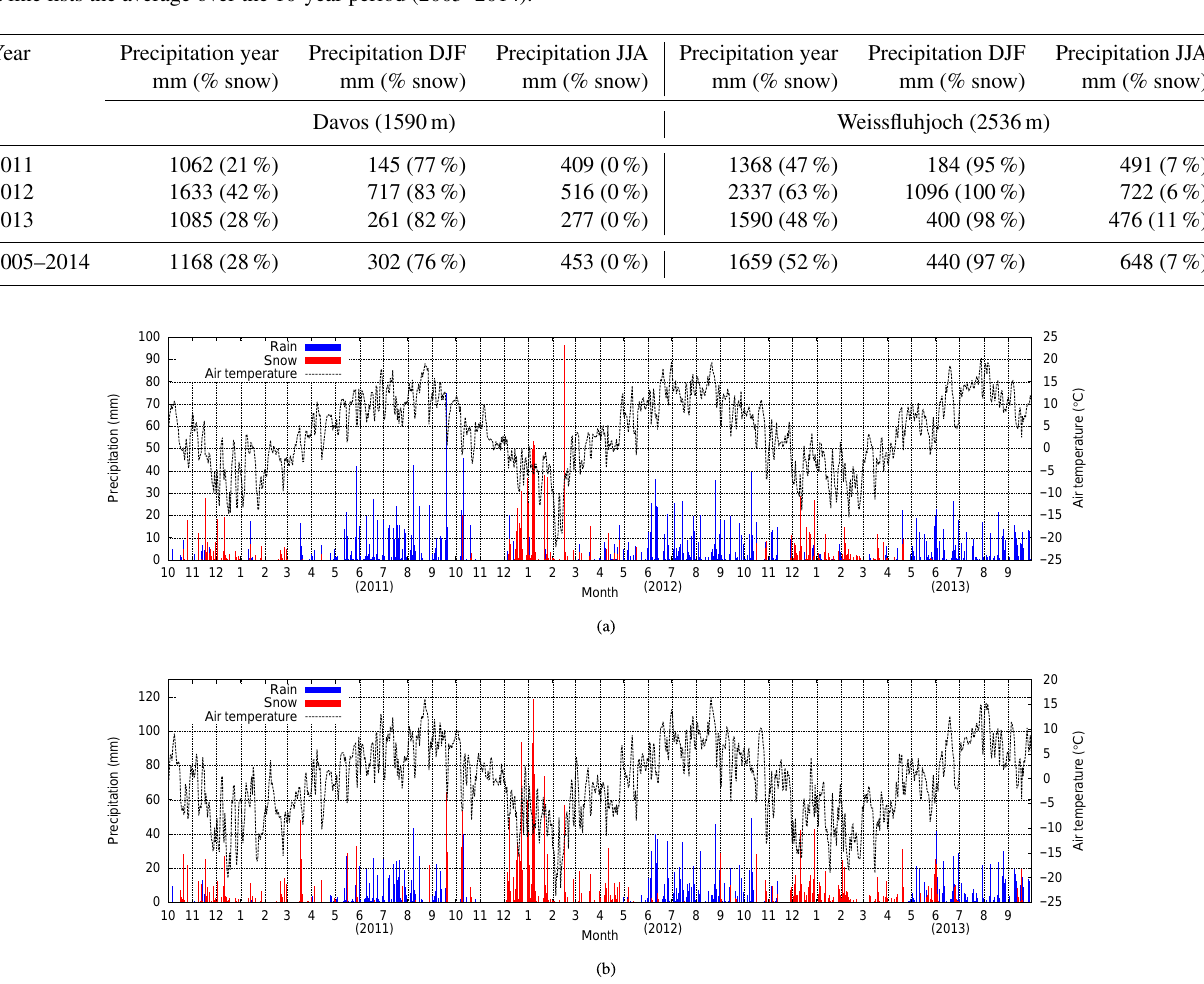
Figure 2. Daily rain and snowfall amounts and daily average air temperature for Davos, 1590m (a) and Weissfluhjoch, 2536ma.s.l. (b) . The separation of precipitation in rain and snowfall is done with half-hourly measurements using an air temperature threshold of 1.2 ◦